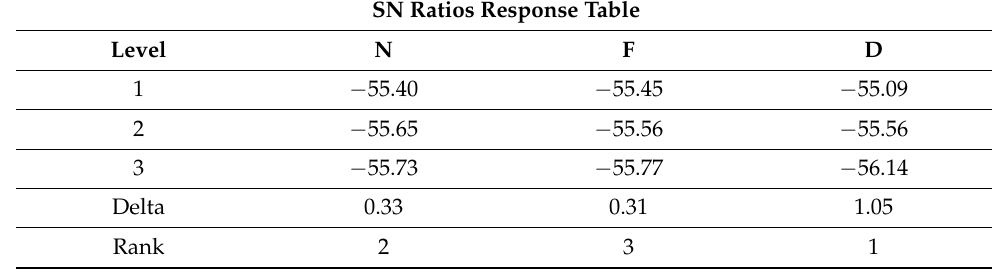
Table 7. Taguchi investigation details of SR and CF vs. N, F, and D.